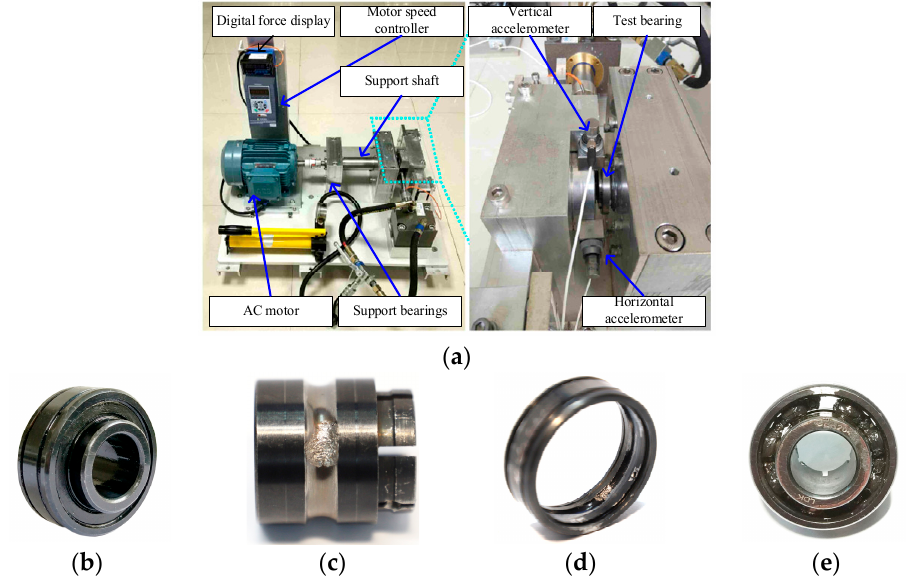
Figure 12. ( a ) XJTU-SY rolling element bearing test bench, ( b ) the test bearing, ( c ) the test bearing with inner race defect, ( d ) the test bearing with outer race defect, and ( e ) the test bearing with cage defect.